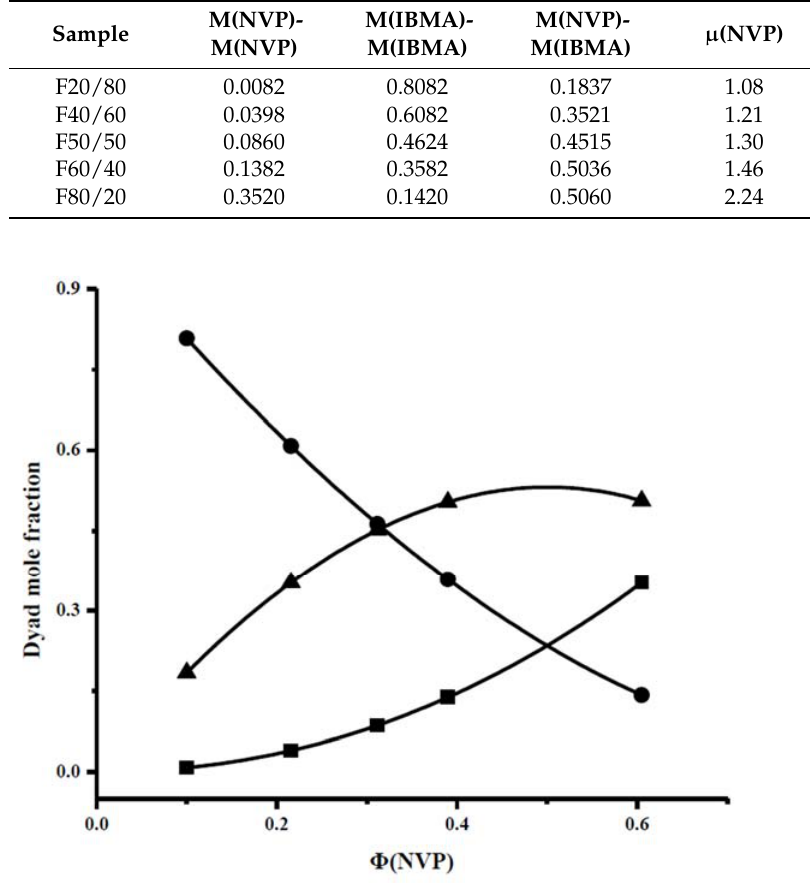
Figure 3. Dyad sequence distributions for the PNVP-stat-PIBMA copolymers via free radical